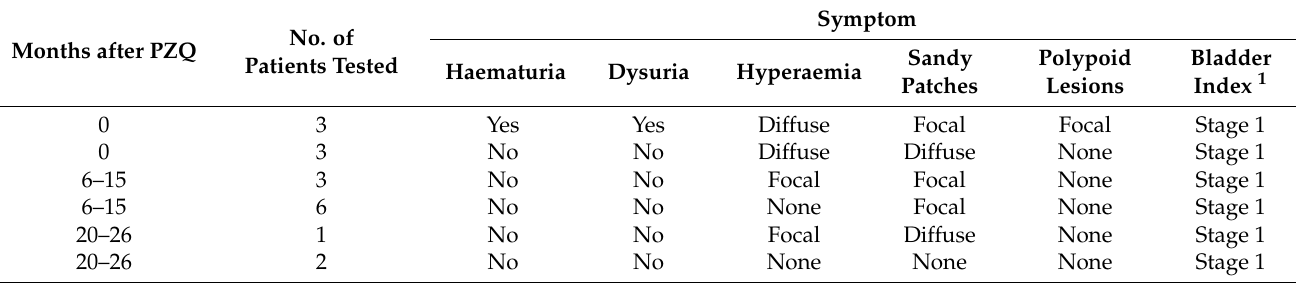
Table 3. Bladder lesions in S. haematobium patients before and after treatment with praziquantel (adapted from Giboda